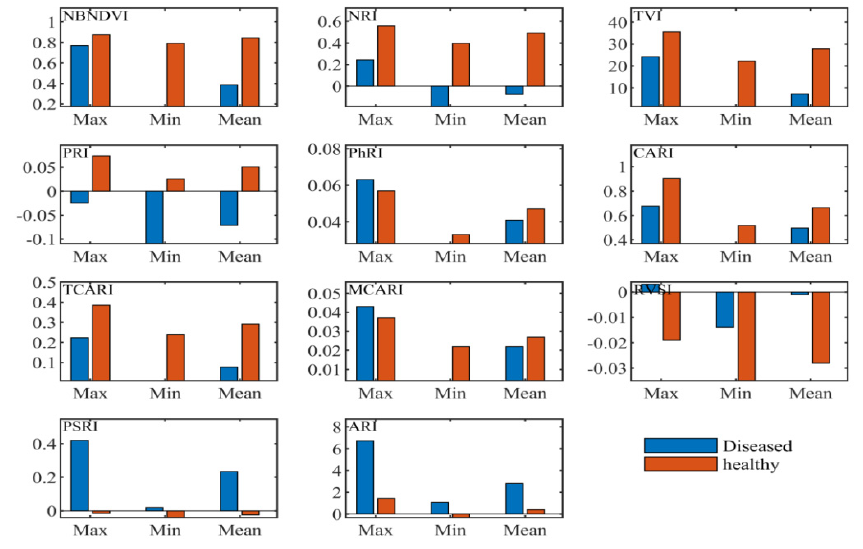
Figure 4. Descriptive statistics of narrow-band vegetation indices.